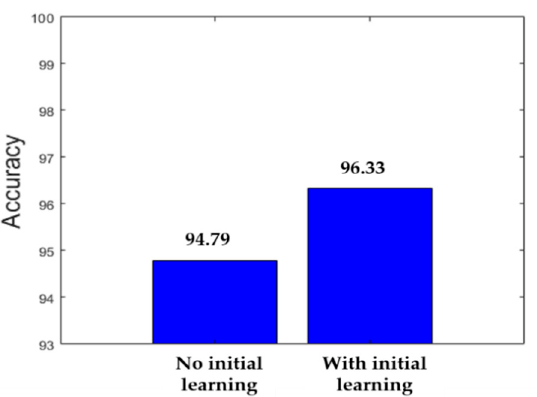
Figure 17. Accuracy improvement with the initial learning in the case of 100% of the training data available.